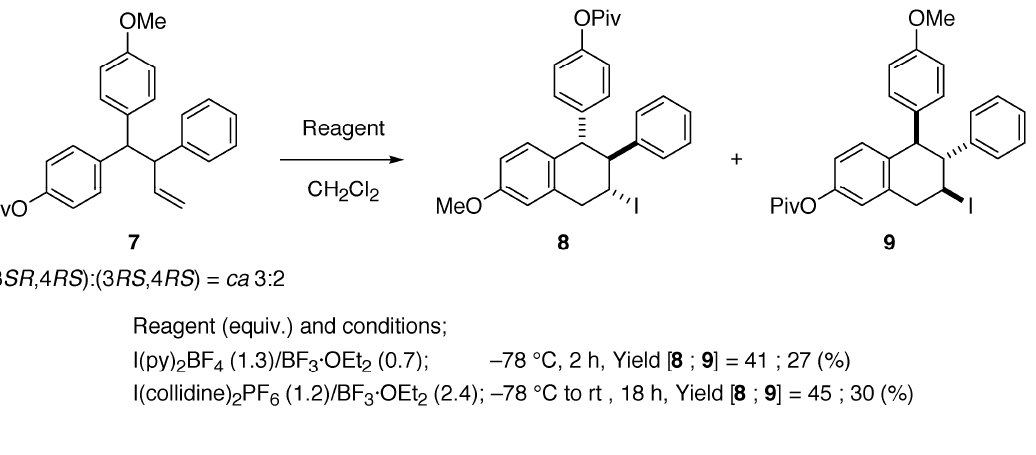
Figure 3. Determination of the positions of methoxy and pivaloyloxy groups in 8 and 9 and the stereochemistry of 8 and 9